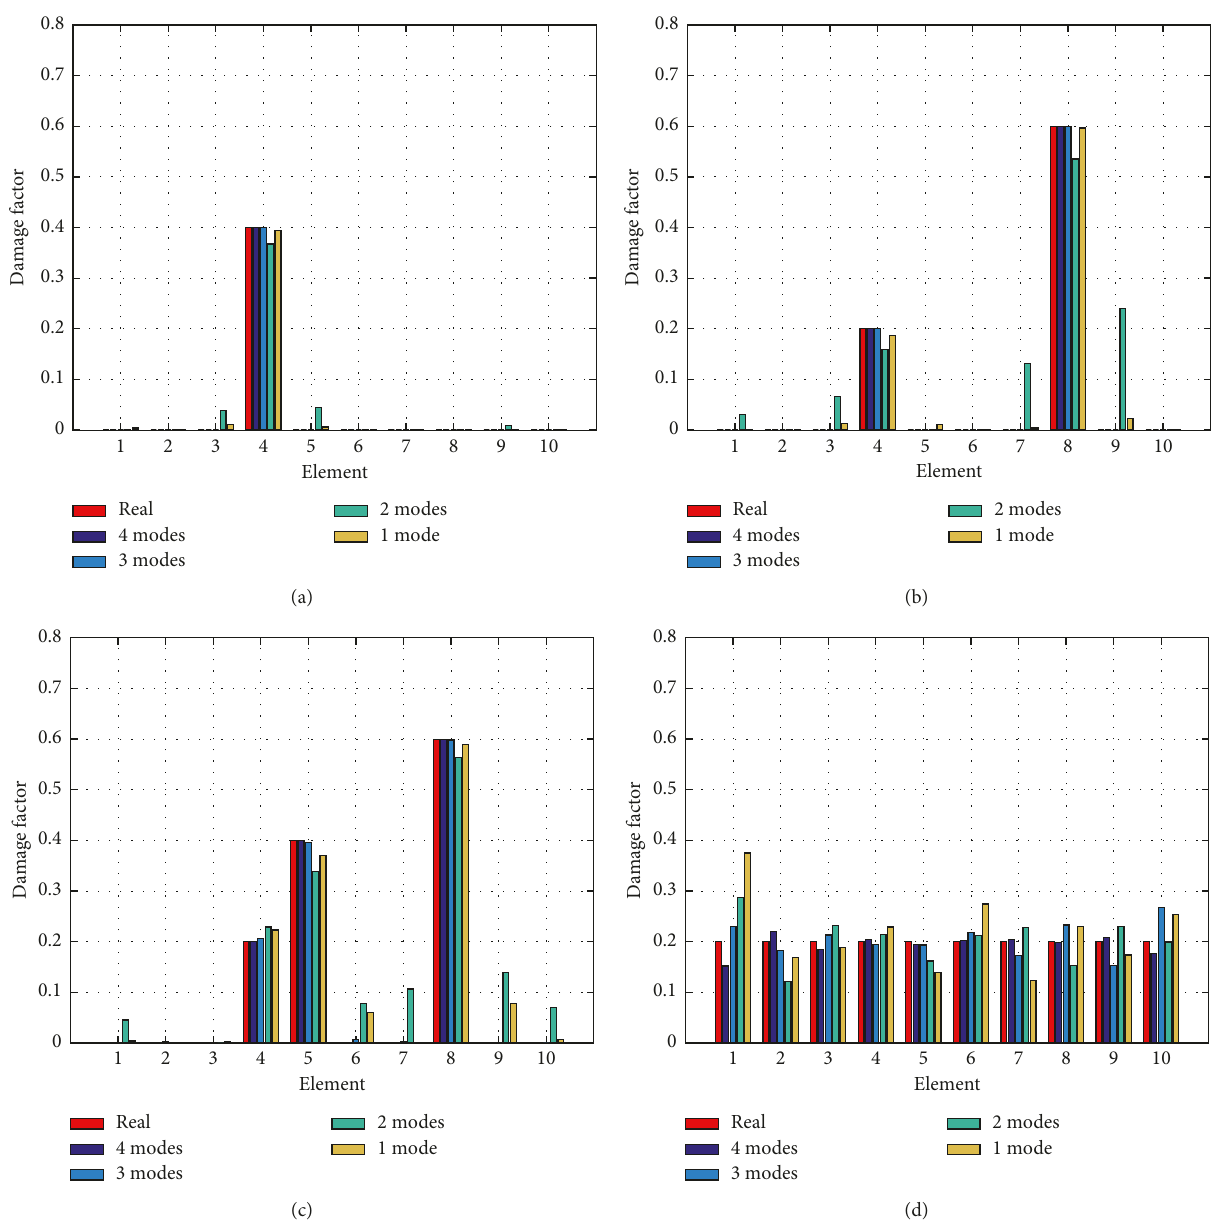
Figure 4: Beam example: damage prediction of the combined criterion for the four different damage scenarios (no noise). (a) Scenario 1, (b) scenario 2, (c) scenario 3, and (d) scenario 4. Table 1: Beam example: norm values for different damage scenarios and 1 to 4 known modes (no noise). Damage Known modes